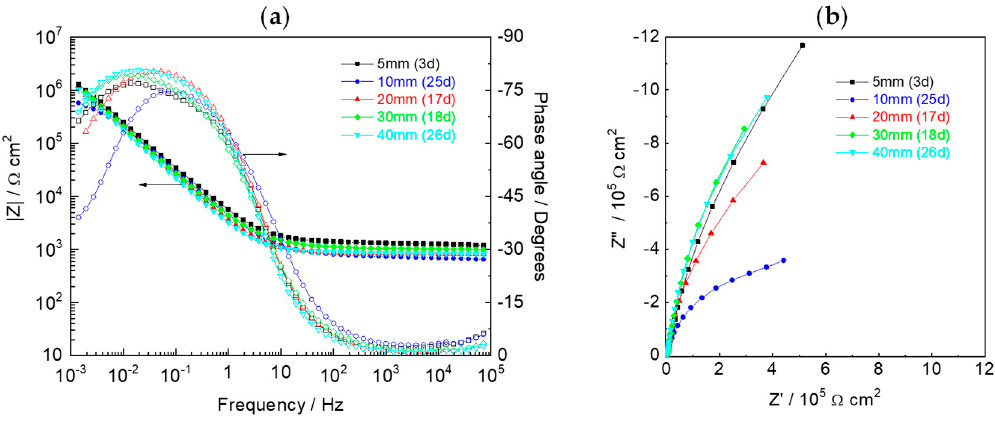
Figure 9. EIS response—( a ) Bode plots and ( b ) Nyquist diagrams—of Fe wires embedded in the mortar before being reached by the acid front. Table 2. Parameters obtained from the impedance spectra in Figure 9. Depth